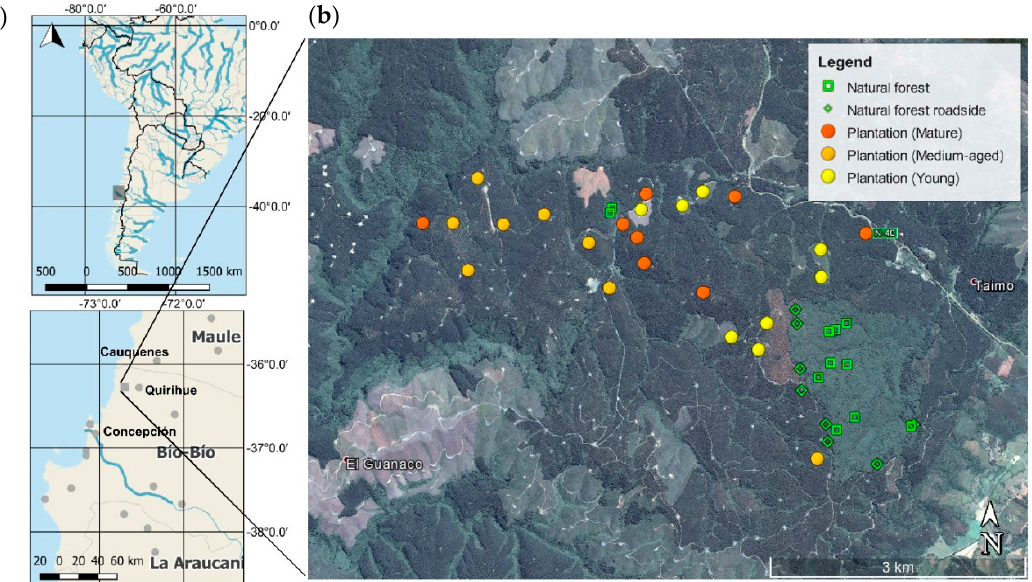
Figure 1. Location of the study area close to the town of Quirihue in the administrative region Bio-Bío, south-central Chile ( a ). The Google earth image © 2018 DigitalGlobe (from 1 January 2013) ( b ) shows the transect position across the study area in different plantation age classes (yellow to orange circles; n = 8 per age class) and in two natural forest remnants (green squares; n = 11). Roadside transects were located adjacent to the plantation interior transects with a minimum distance of 50 m ( n = 8 per age class; not displayed), roadside transects adjacent to the natural forest were established within the large natural forest remnants (green diamonds, n = 8).